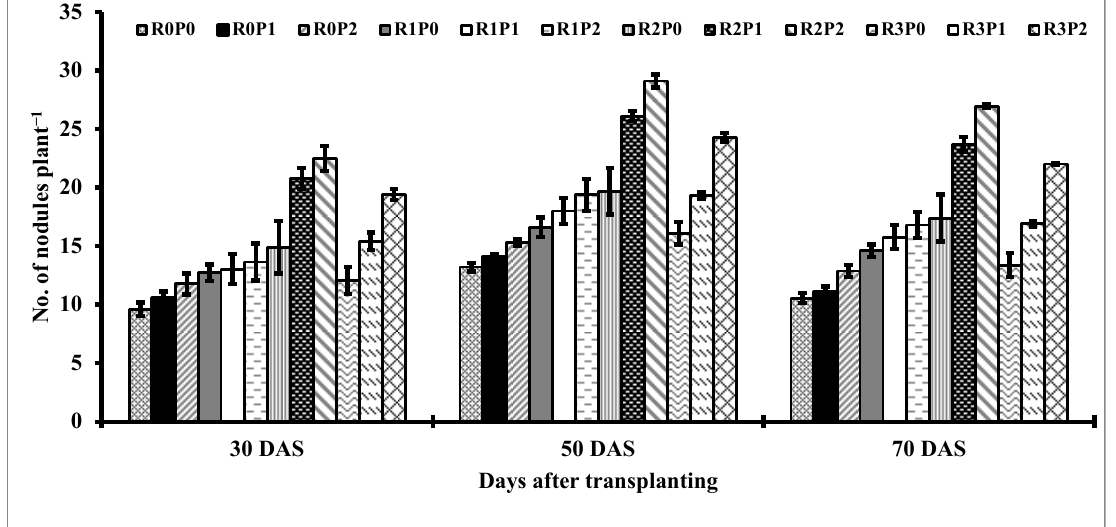
Figure 6. Interaction effect of Rhizobium japonicum and Pseudomonas striata on number of nodules plant − 1 of soybean at different days after sowing. (mean ± SE, n = 3); R 0 : Control (no nitrogen and R. japonicum ), R 1 : 100% N without R. japonicum , R 2 : 50% N with R. japonicum , R 3 : only R. japonicum inoculant, P 0 : Control (no P and no P. striata ), P 1 : 100% P without P. striata and P 2 : 75% P with P. striata . Two-way ANOVA showed a significant interaction ( p ≤ 0.05) between R. japonicum and P. striata . Mean values sharing similar letters are statistically insignificant. Table 5. Effect of Rhizobium japonicum and Pseudomonas striata on dry weight and nitrogen content of nodules at different days after sowing.